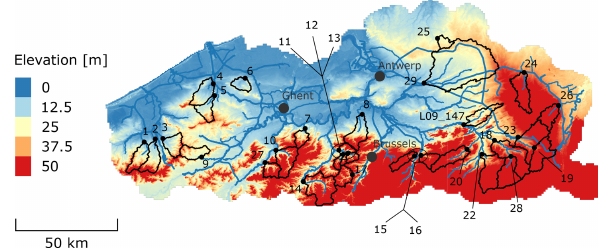
Figure 1. Selected catchments in the Flanders area of